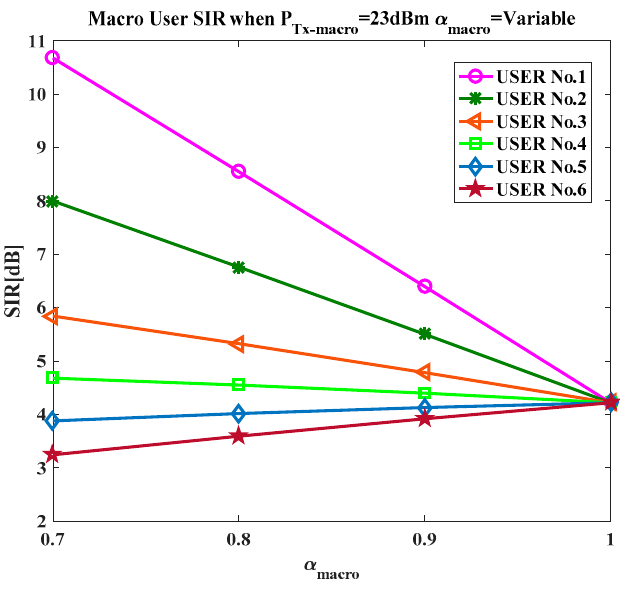
α macro in the homogenous macro cell